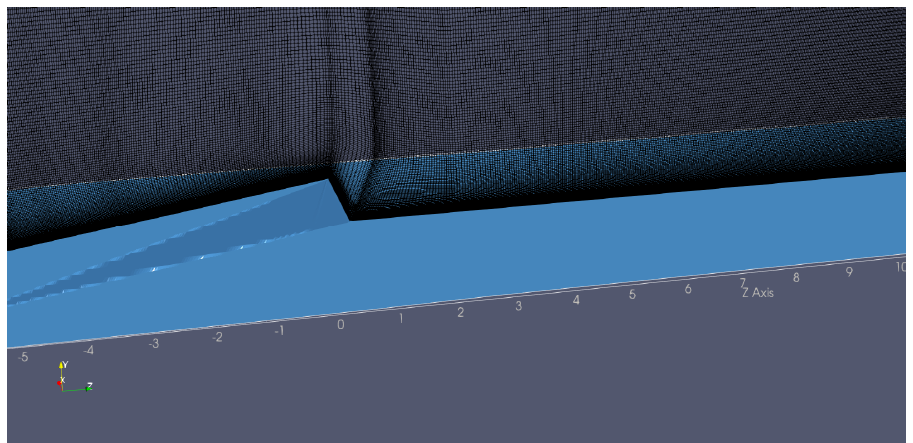
Figure 2. Grids around the tip of MVG.